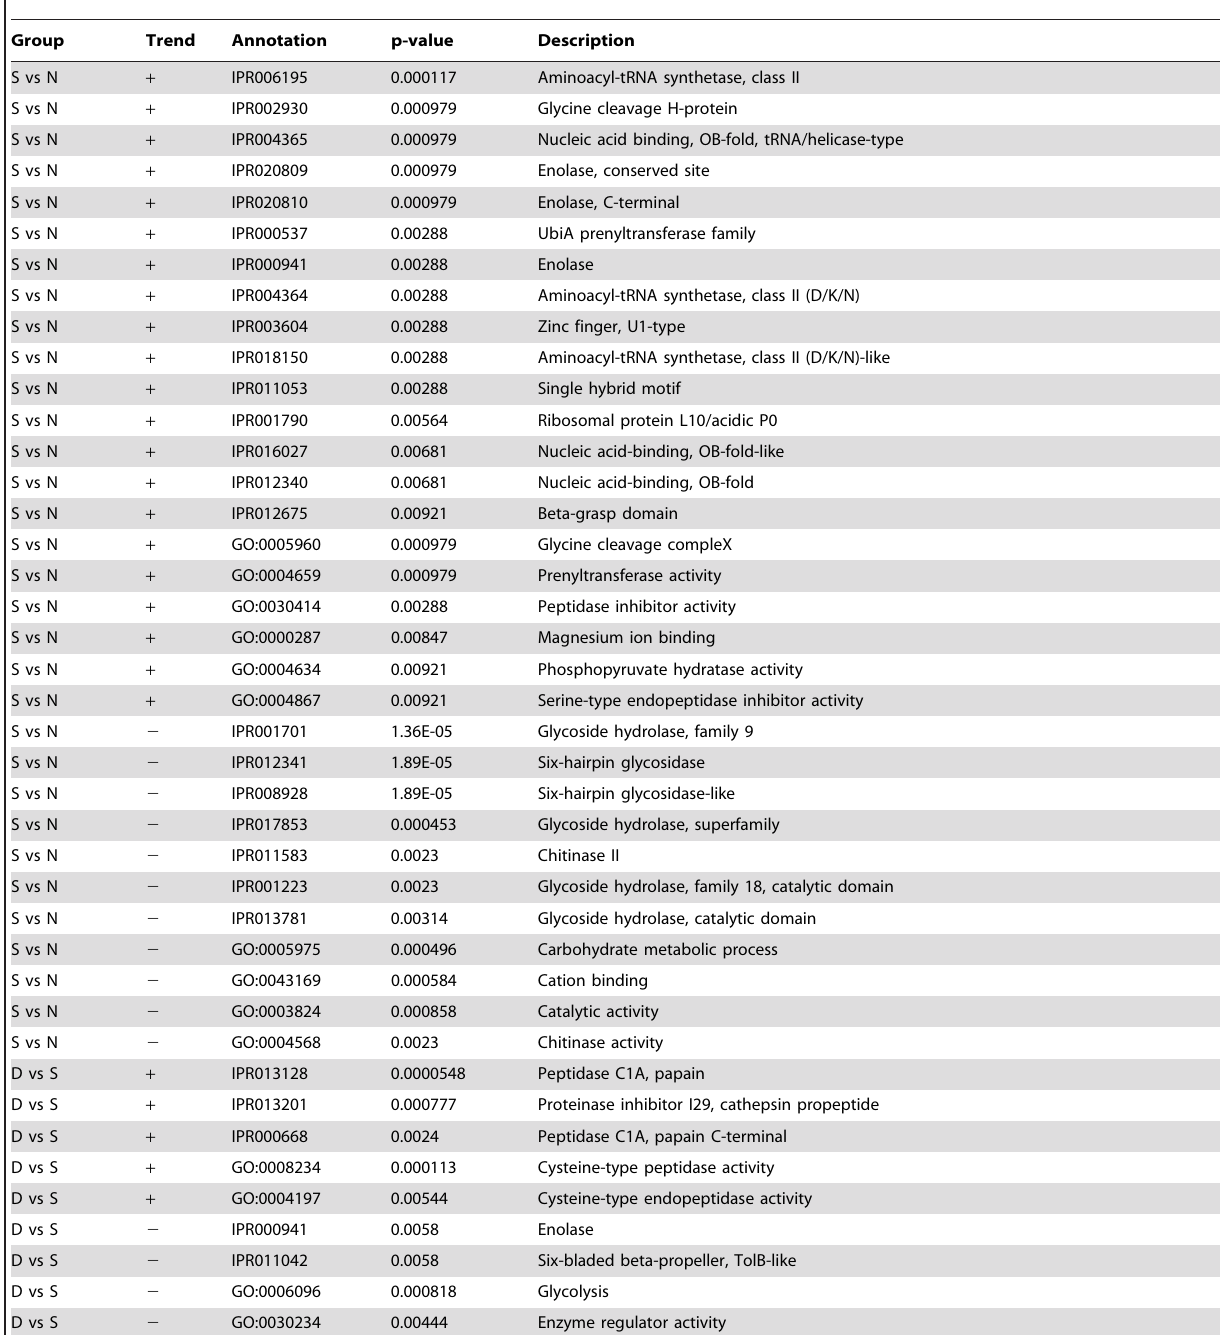
Table 5. List of the Interpro domains and GO terms differentially regulated by XOSG removal (S) or by D-cHH-injection (D), detected by the Hypergeometric